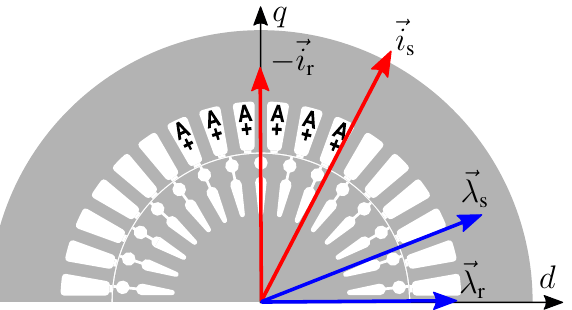
Figure 3. In MS FEA, stator and rotor currents have to be imposed according to the inverse- Γ model: the condition λ rq = 0 has to be verified in order to properly analyze the machine (the rotor flux linkage space vector lies along the d